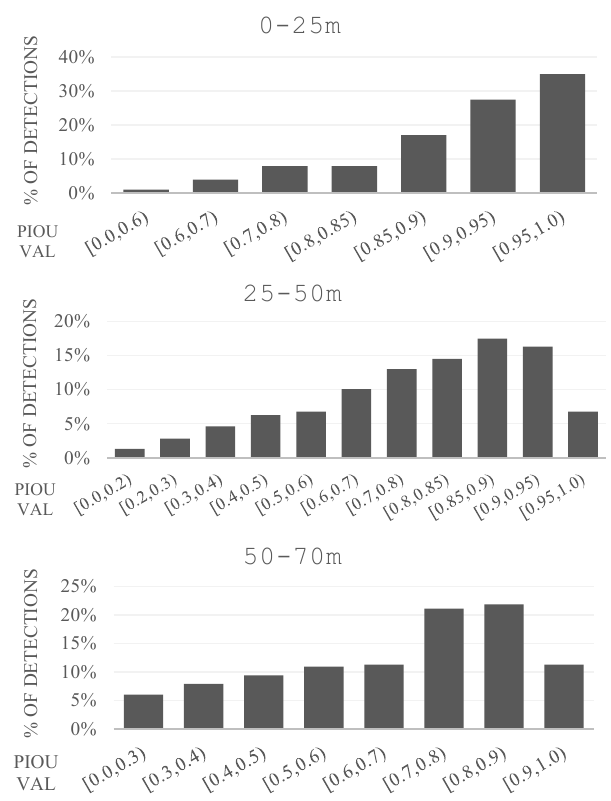
Figure 14. The Point IoU Histograms, for the three distance